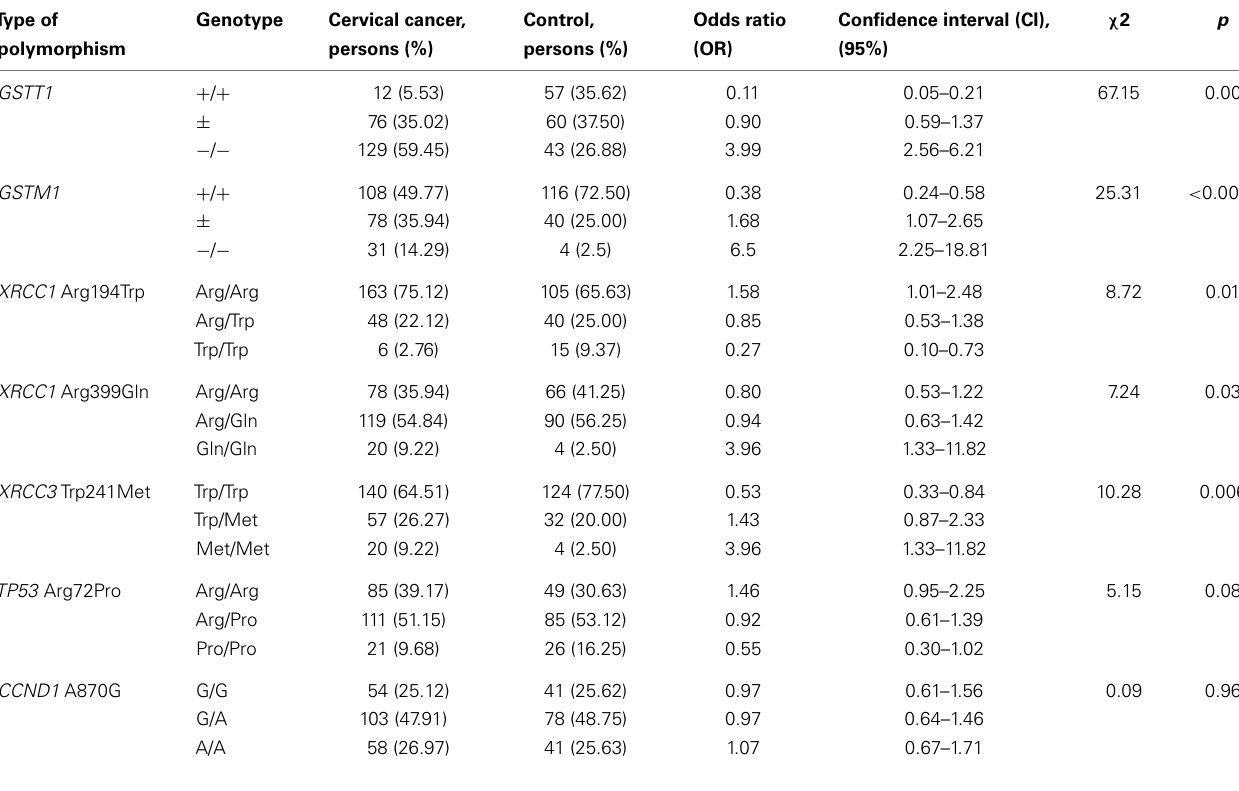
Table 7 |Association between genetic polymorphism and development of cervical cancer. Type